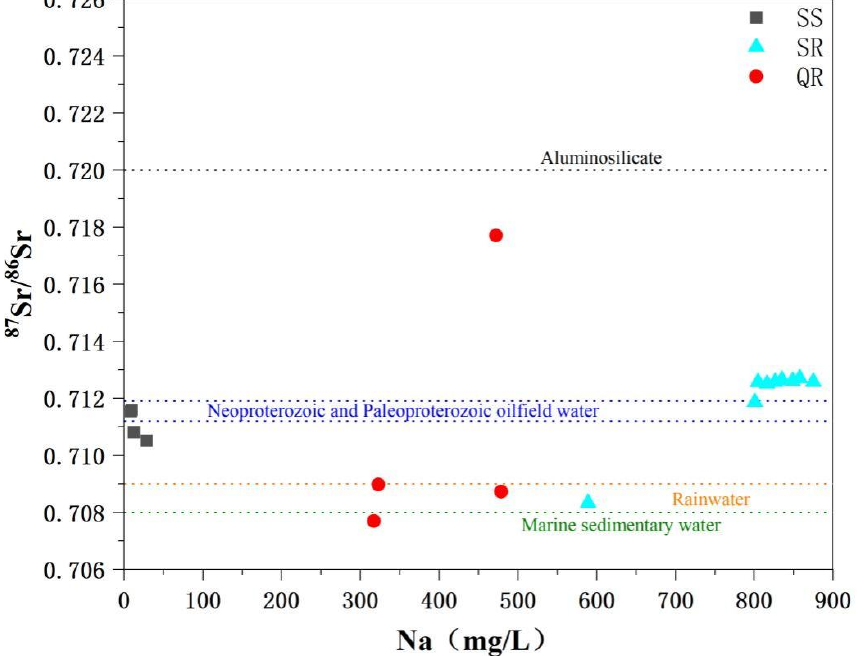
Figure 6. Comparison of Sr isotopic ratios to Na concentrations in the geothermal fluids.